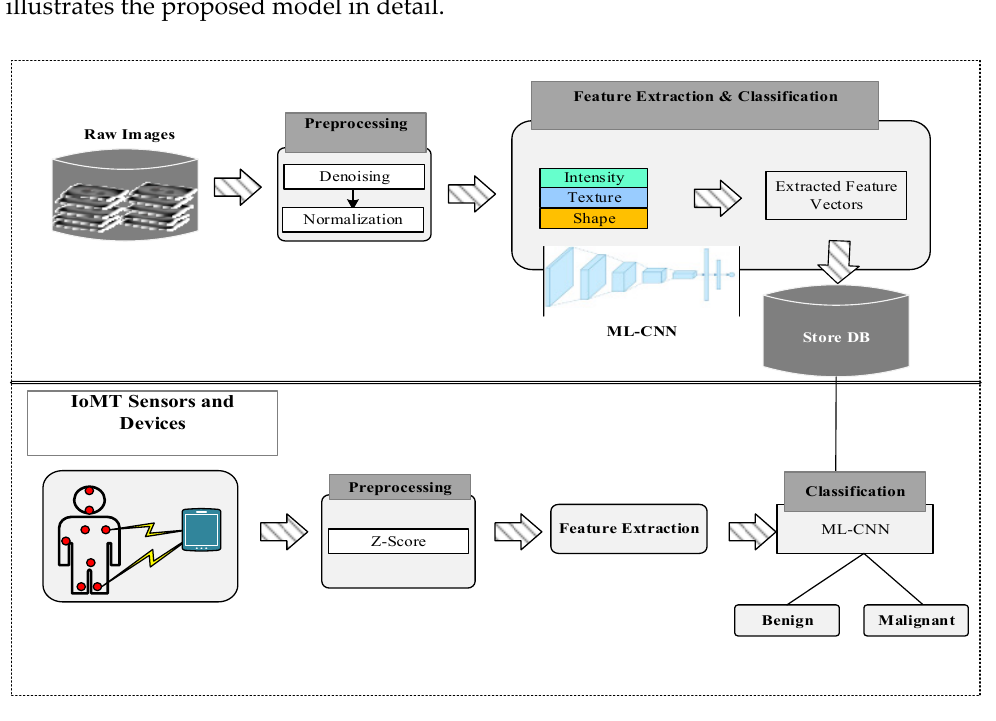
Figure 2. System